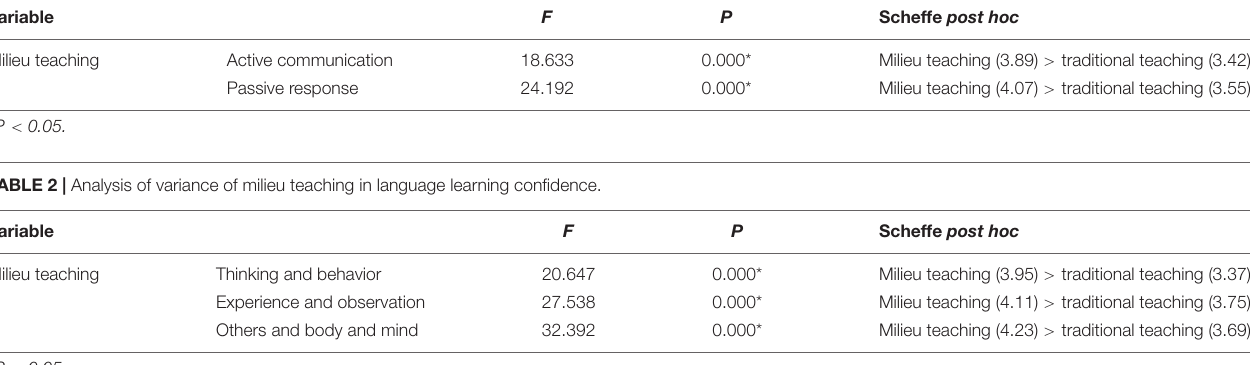
TABLE 1 | Analysis of variance of milieu teaching in communication skills. Variable